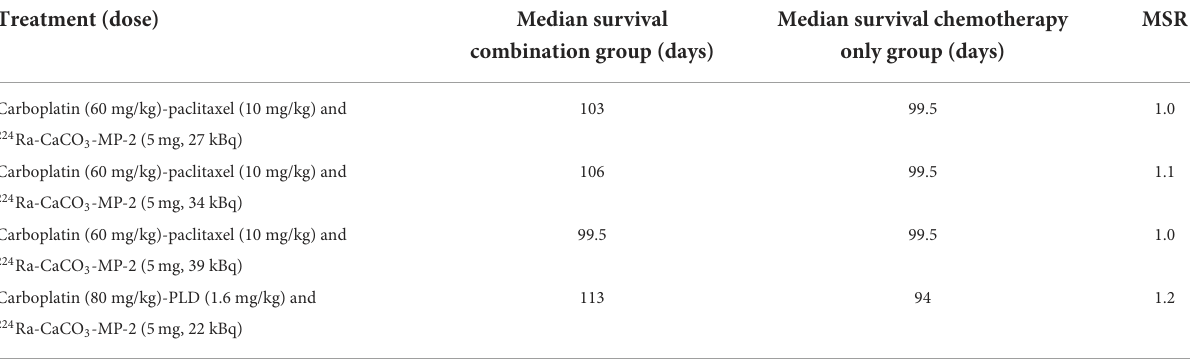
TABLE 3 Median survival ratios (MSRs) for 224 Ra-CaCO 3 -MP combined with chemotherapy compared to chemotherapy as a single treatment. Treatment (dose) Median survival